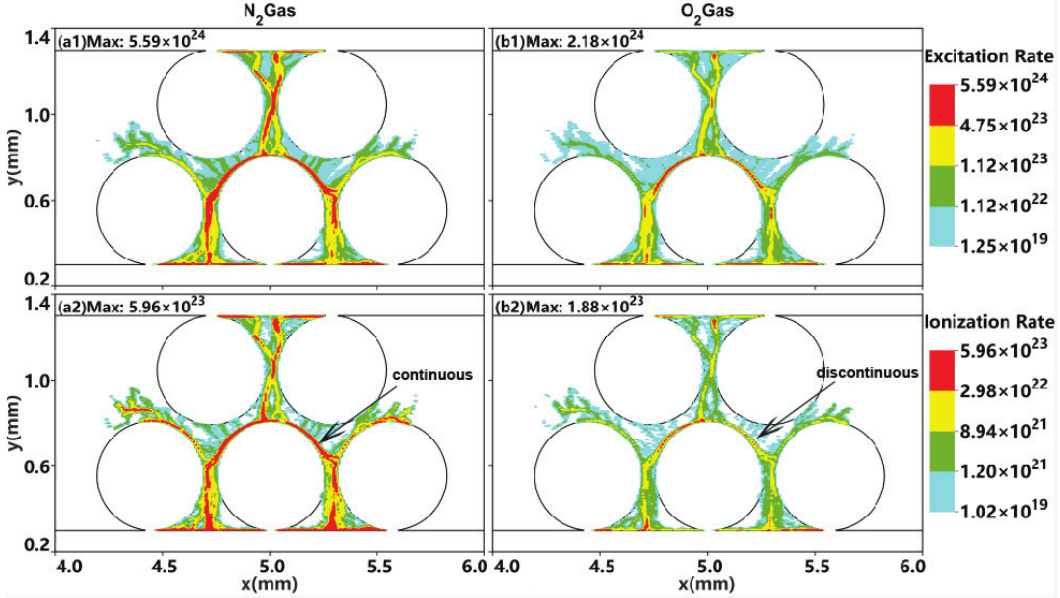
Figure 5. ( a1 , b1 ) Electron impact excitation rate (m − 3 s − 1 ) and ( a2 , b2 ) electron impact ionization rate (m − 3 s − 1 ), at 0.8 ns for a driving voltage of − 20 kV, in an air discharge, for the nitrogen ( a1 , a2 ) and oxygen ( b1 , b2 ) components. The same color scale is used in all panels to allow comparison. The maximum values are noted in the